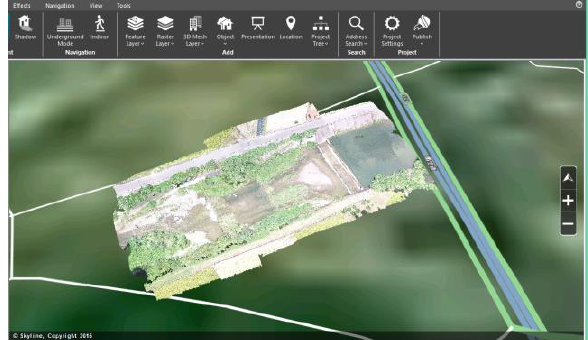
Figure 10. Point cloud data in